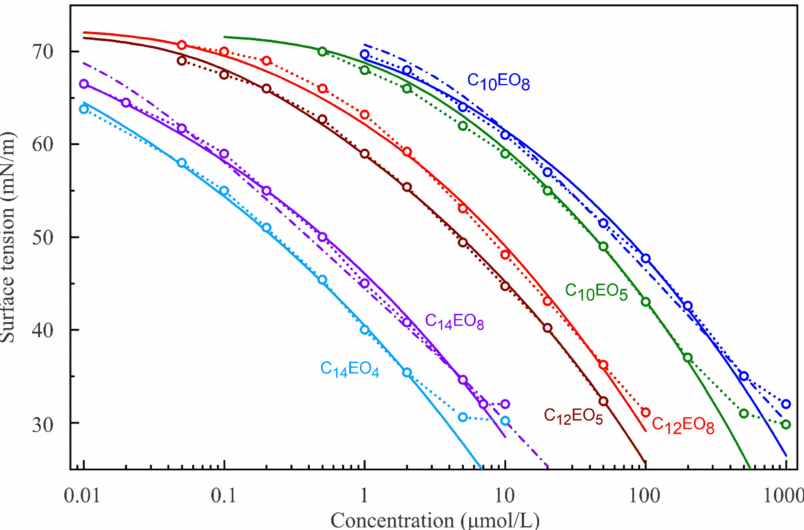
Figure 1. Experimental surface tension isotherms for solutions of six selected C n EO m surfactants (symbols) and the respective theoretical isotherms (solid lines) calculated with the reorientation model and the parameter sets given in Table 1. The theoretical isotherms for C 10 EO 8 and C 14 EO 8 calculated with the Frumkin model and the parameter sets presented in Table 2 (dash-dotted lines) are also presented for comparison. The dotted lines are guides for the